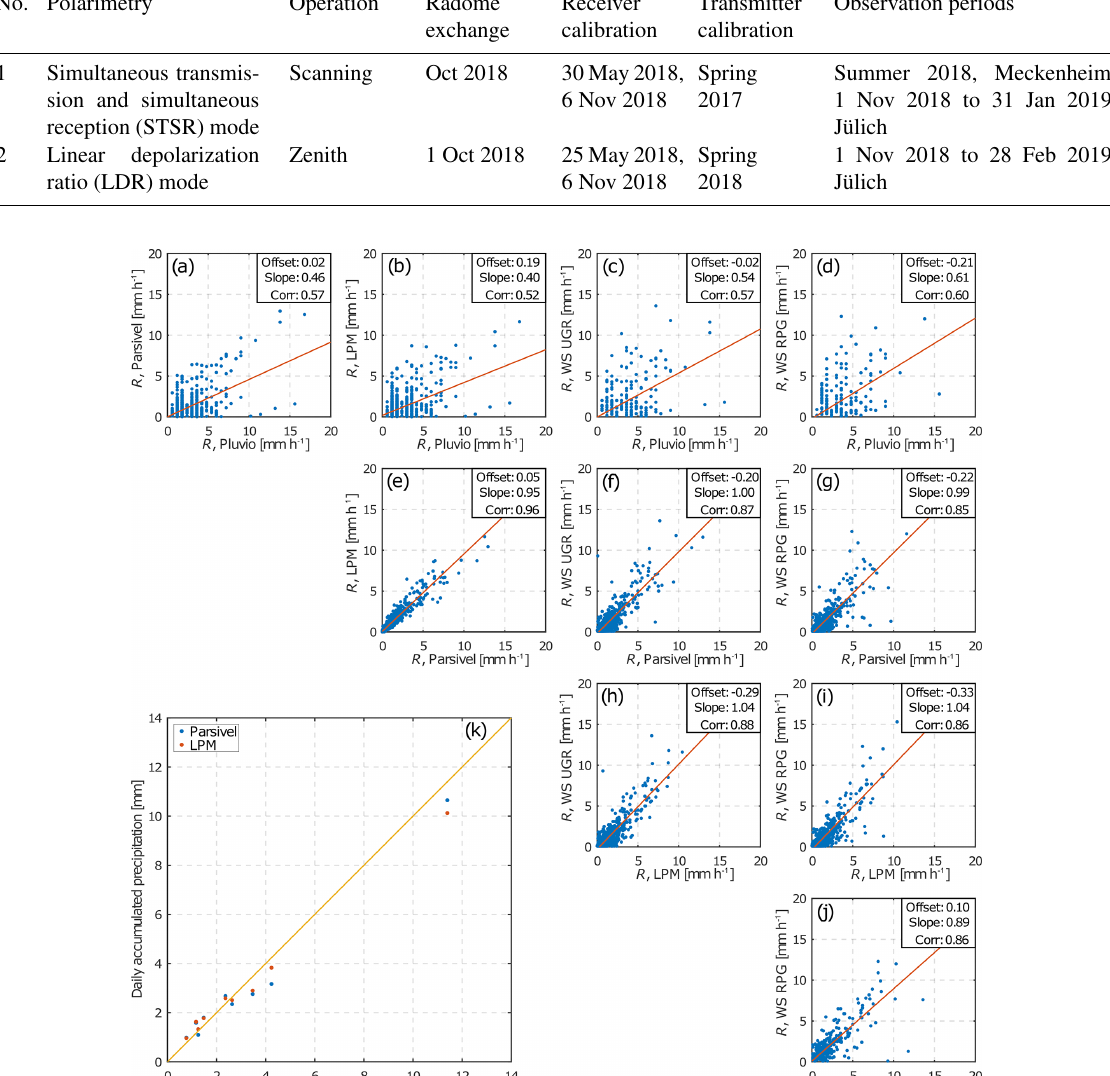
parison is observations from 1 November 2018 to 6